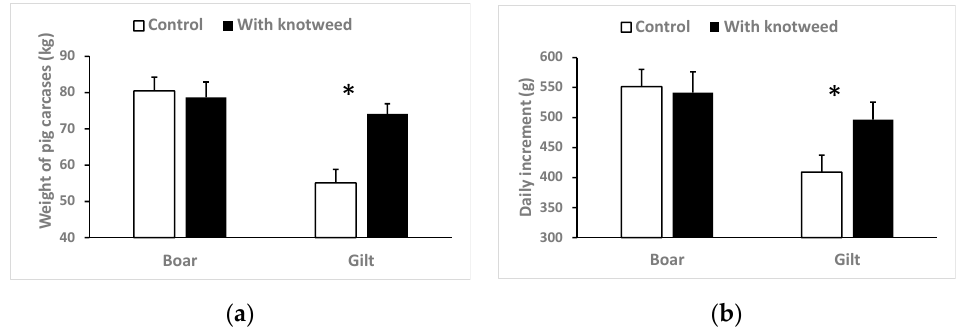
Figure 2. Weight of pig carcasses (boars and gilts) at the end of the experiment ( a ) and the average daily weight increment since birth to 19 November 2019 ( b ). Means + SEM. Difference significant on p < 0.05 marked by an asterisk.